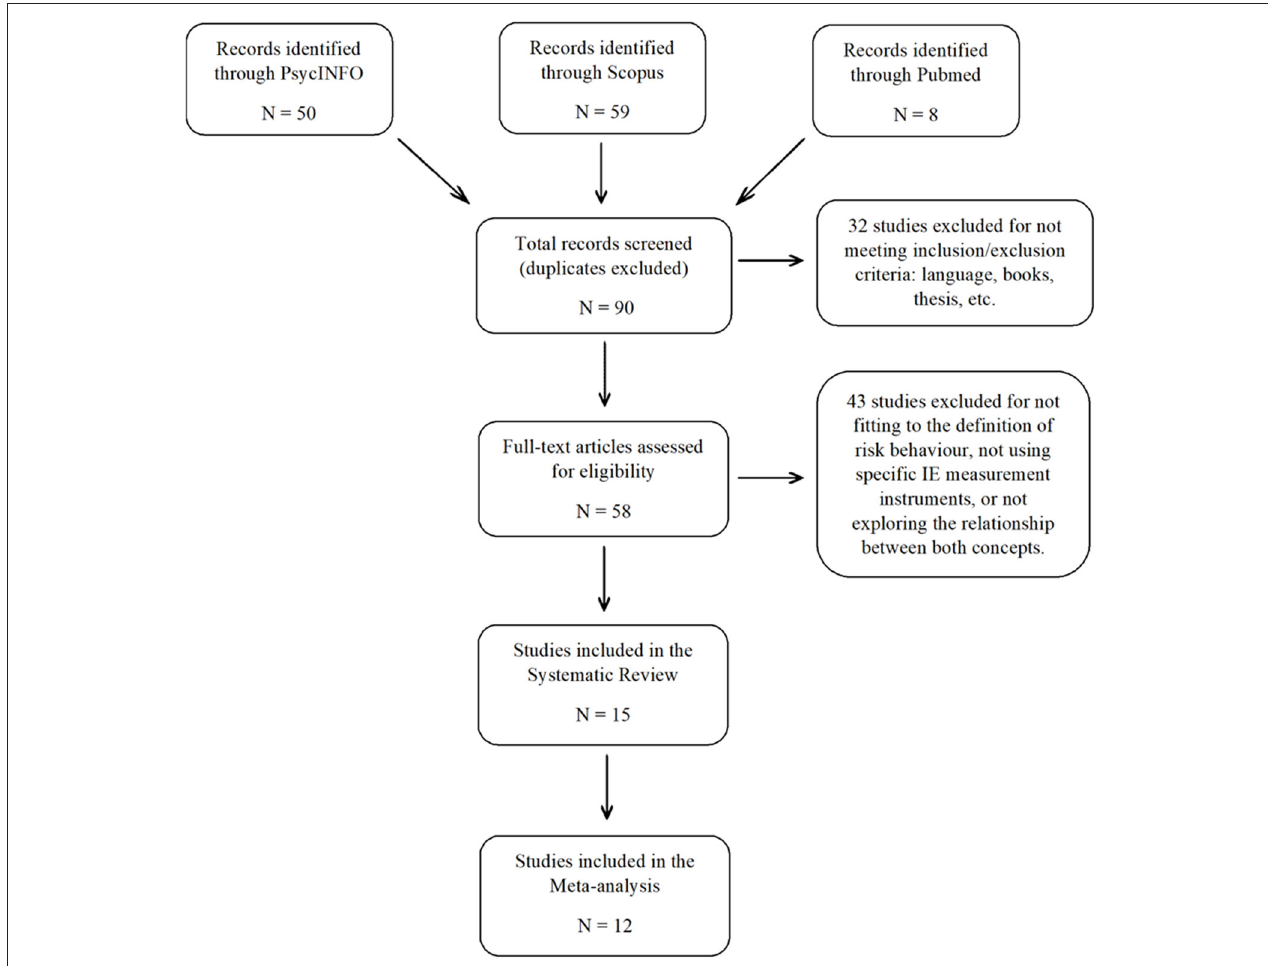
FIGURE 1 | Flow chart of the search